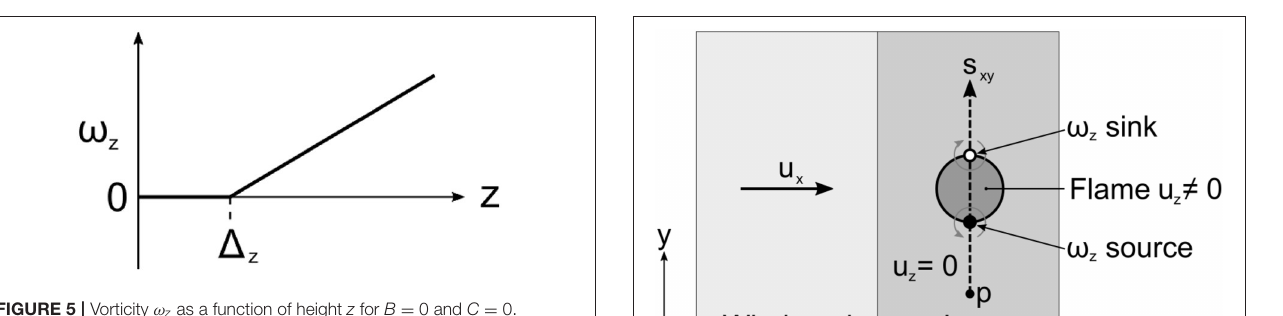
FIGURE 5 | Vorticity ω z as a function of height z for B = 0 and C = 0.